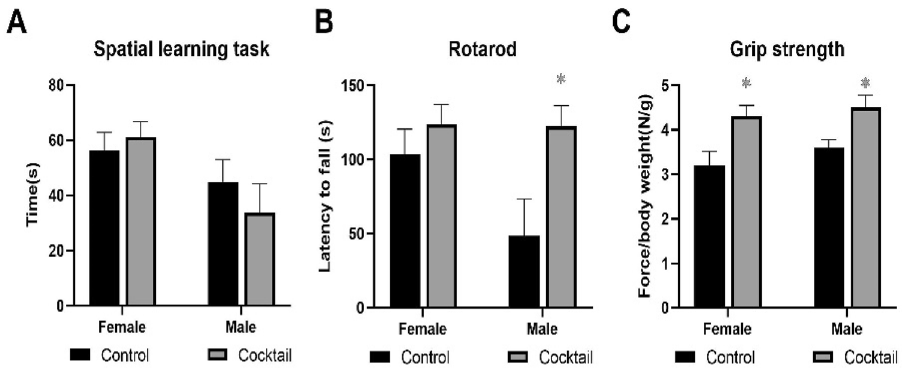
Figure 7. Performance tests were conducted in HET3 mice at 23 months of age, 3 months after being started on chow containing the drug cocktail or placebo. (A) Values for the box maze were standardized times in seconds to find the escape hole in trial 3. (B) Values for the rotarod were standardized times in seconds staying on the rotating rod. (C) Values for grip strength were standardized force in newtons per body weight measuring the ability to maintain forepaw grip from a parallel meter bar. N = 12–14. *P < 0.05; two-tailed, unpaired Student’s t-test.